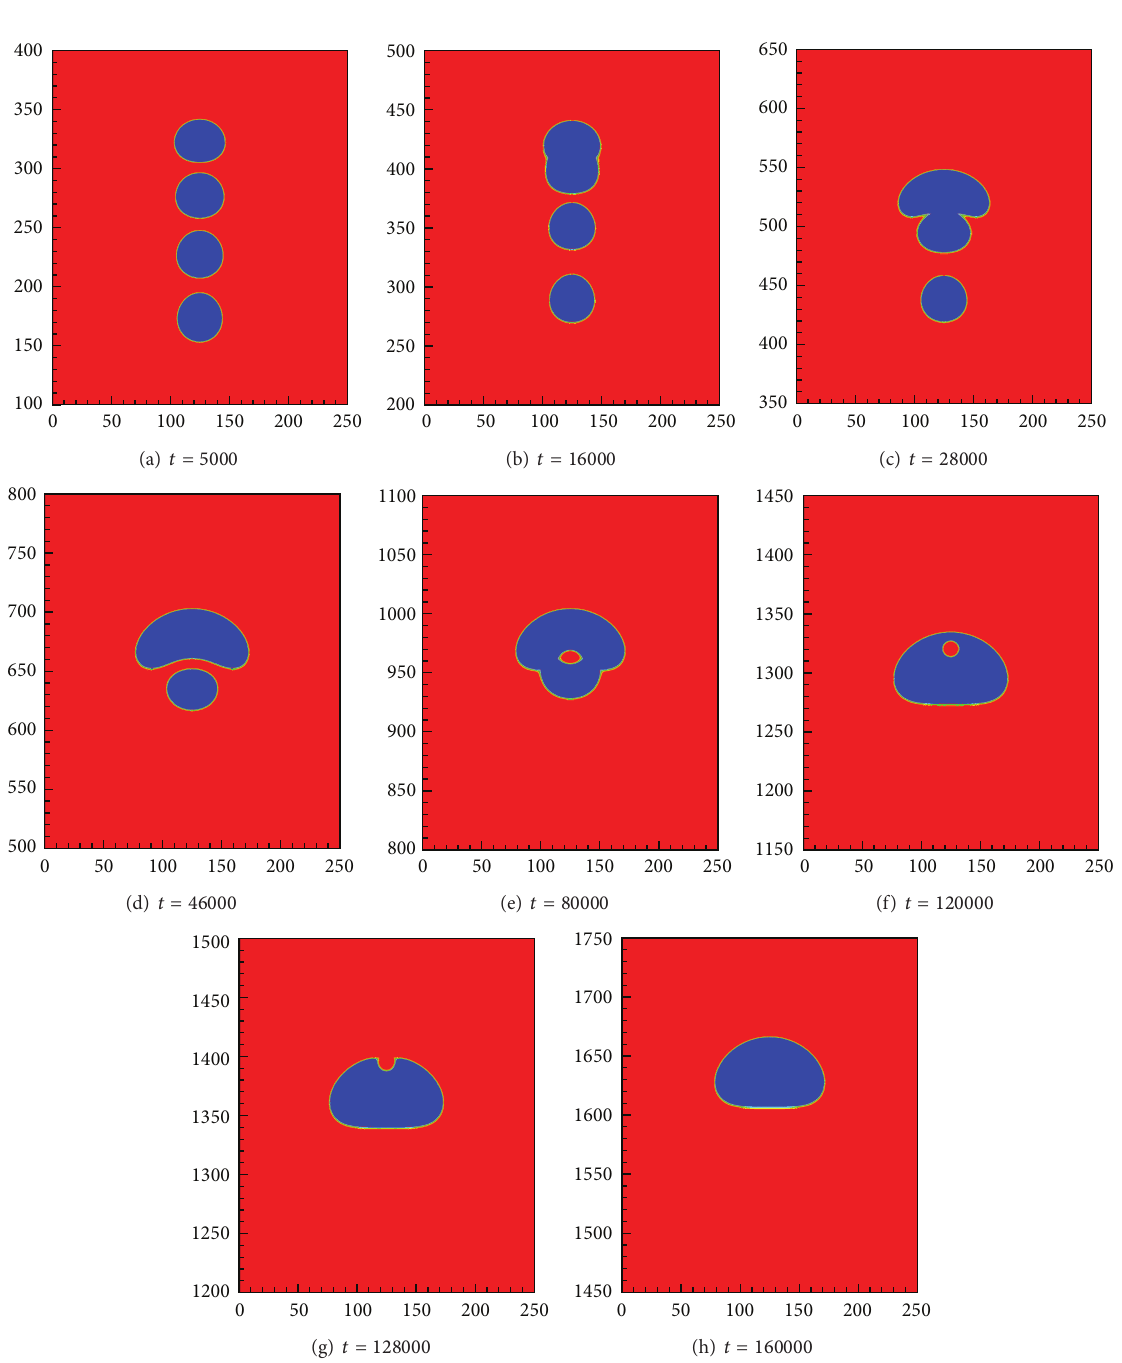
Figure 5: The contour of order parameter of four bubbles for Eo = 2